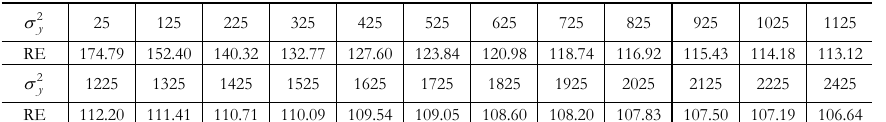
RE of the POONAM estimator over the GS